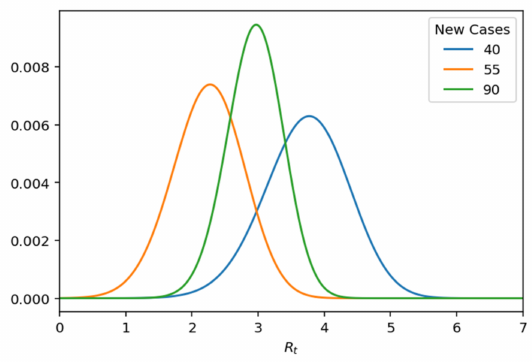
Figure 14. Likelihood of R t given k .